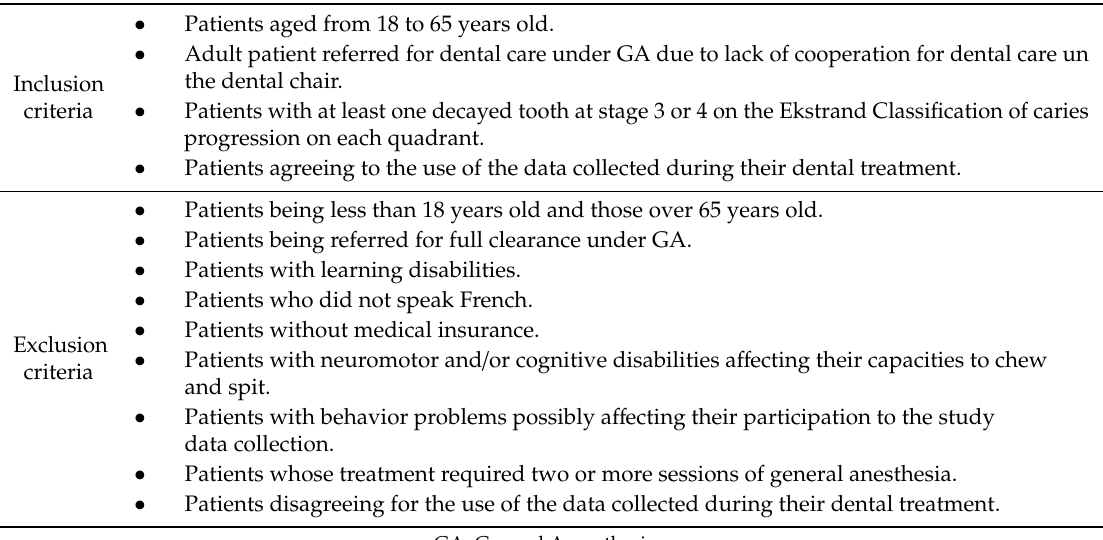
Table 2. Criteria for inclusion and